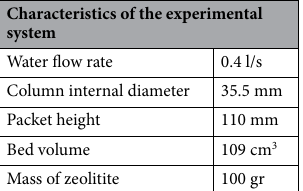
Table 4. Characteristics of the column experimental system.